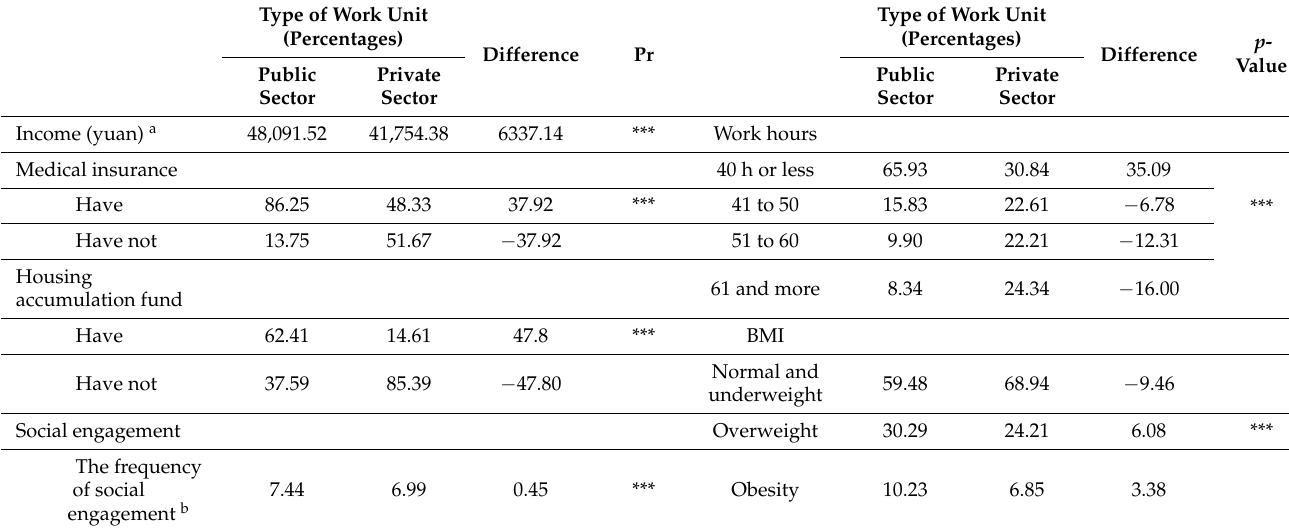
Table 4. Differences between public and private sectors in welfare, social engagement, work hours, and BMI (100%).